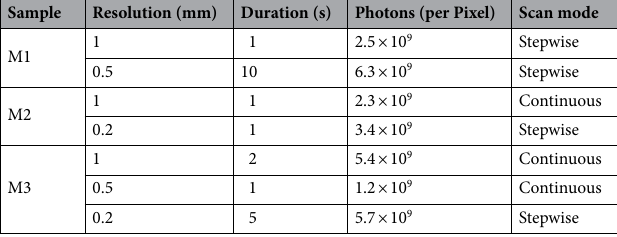
Table 1. Summary of the main parameters for the different